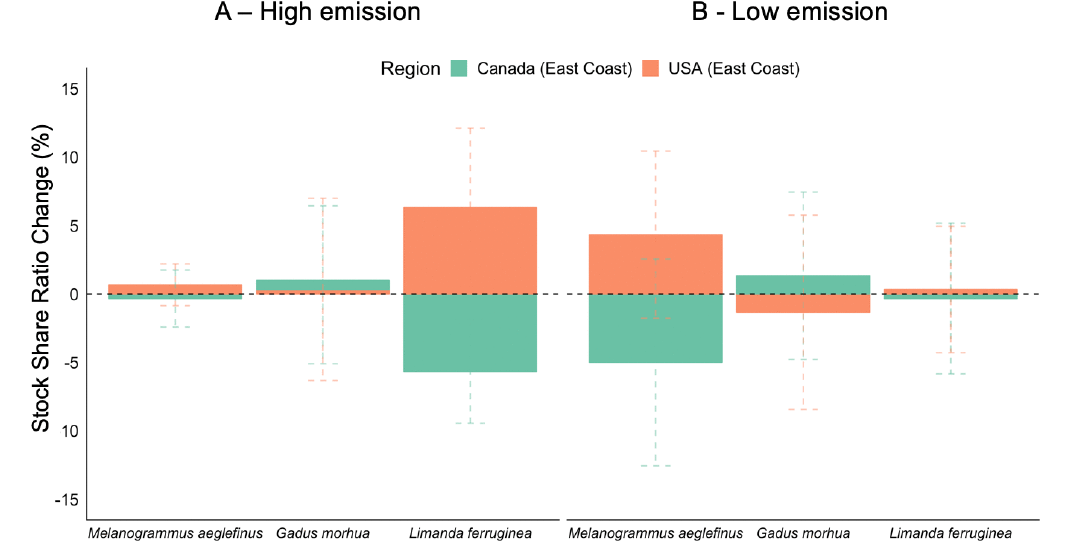
Fig. 5 . Changes in maximum catch potential (MCP) stock-share ratio for Gulf of Maine under (A) high emission scenario and (B) low emission scenario for midcentury (2041–2060) relative to 2005–2014. Values represent the mean of three Earth system models (ESM); error bars represent ±